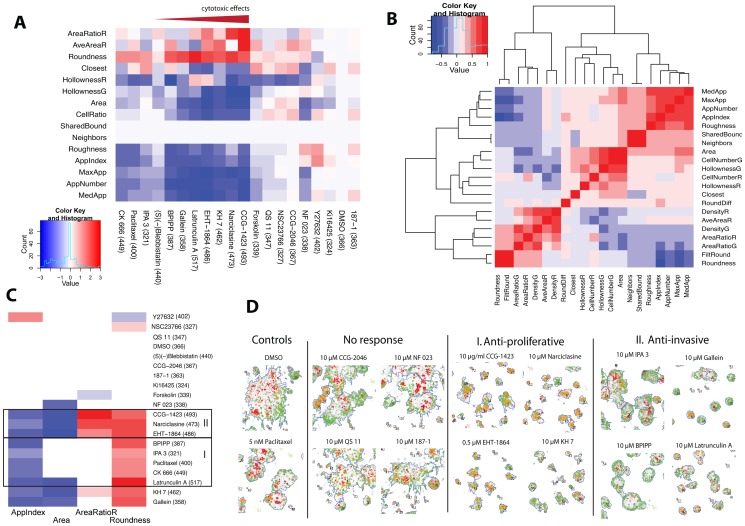
Exemplary screen based on the PC-3 spontaneous invasive transformation model.PC-3 spheroids were treated with 19 compounds mainly targeting integrity, function and organization of the actin cytoskeleton. 172–424 multicellular structures for each treatment were analysed with AMIDA program. (A) A morphometric heatmap showing standardized differences in medians between the treatments and the control for 15 morphological parameters and all 19 compound treatments. Morphological responses clustered into three functional groups. Increasing cytotoxicity, measured by the AreaRatioR parameter – based on presence of dead cells stained with ethidium homodimer - is indicated by the red gradient arrow. (B) Correlation map (nonparametric Spearman) indicating the similarity (positive correlation, red) or dissimilarity (negative correlation, blue) for 21 of AMIDAs morphometric parameters. (C) Bonferroni-corrected and Mann-Whitney U-test filtered morphometric heatmap (threshold p>0.05) focusing on four selected, most informative parameters (AppIndex, AreaRatioR, Roundness, Area). The graph highlights compounds causing mainly growth-inhibition and cytotoxicity (group II), and those that enhance spheroid symmetry and reduce number of invasive protrusions (group I). (D) The image panel shows representative, segmented PC-3 spheroids for groups I and II, compared to DMSO and paclitaxel controls, after six days of drug treatment.